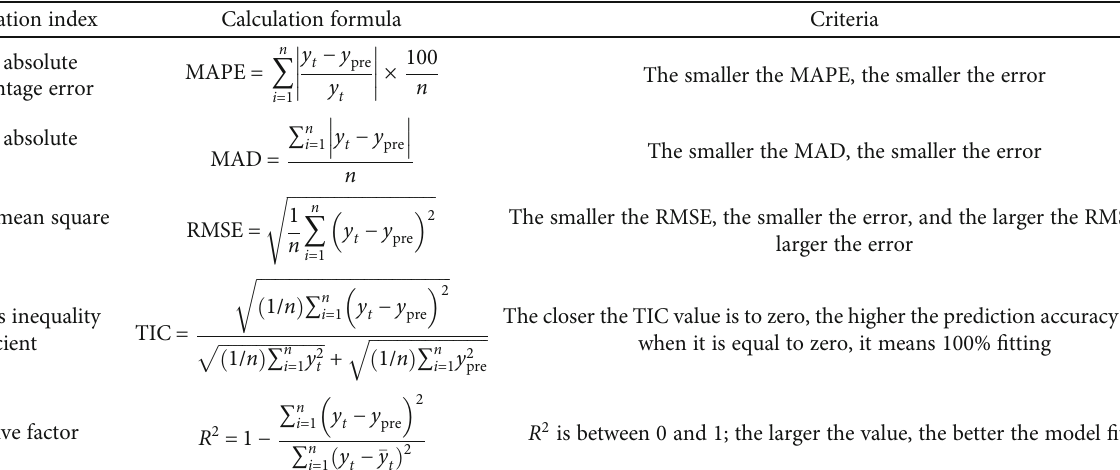
Table 3: Evaluation index of the regression model.